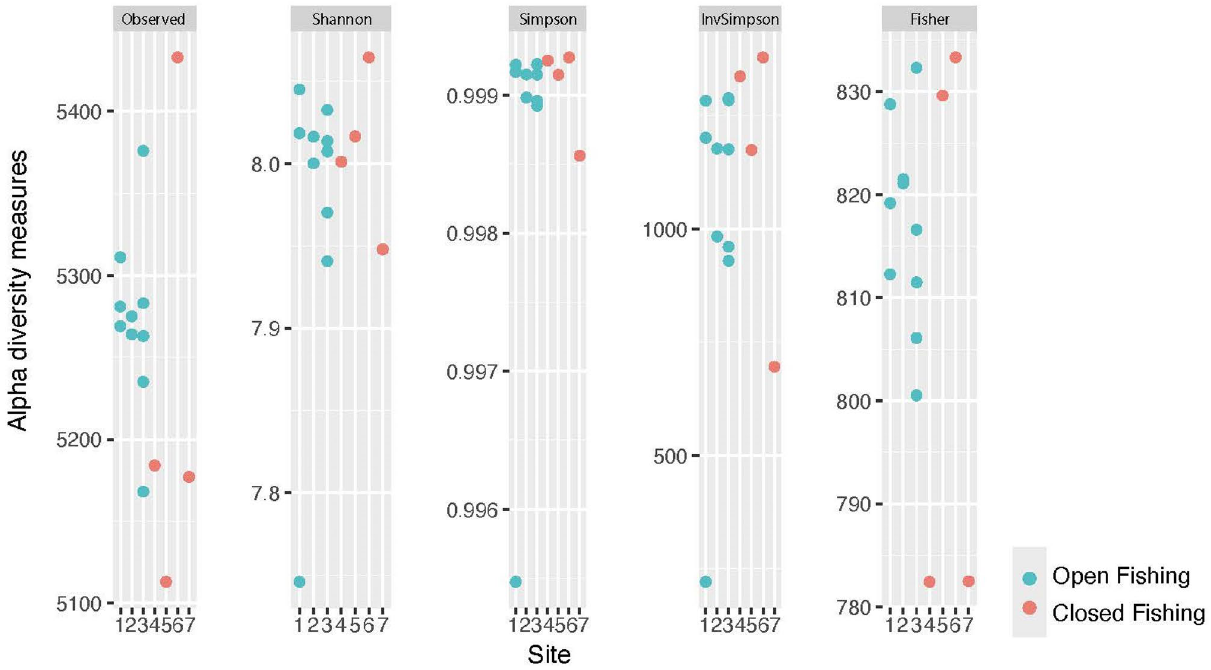
Figure 4. Alpha diversity measures based on species abundance across all sample sites organized by site.